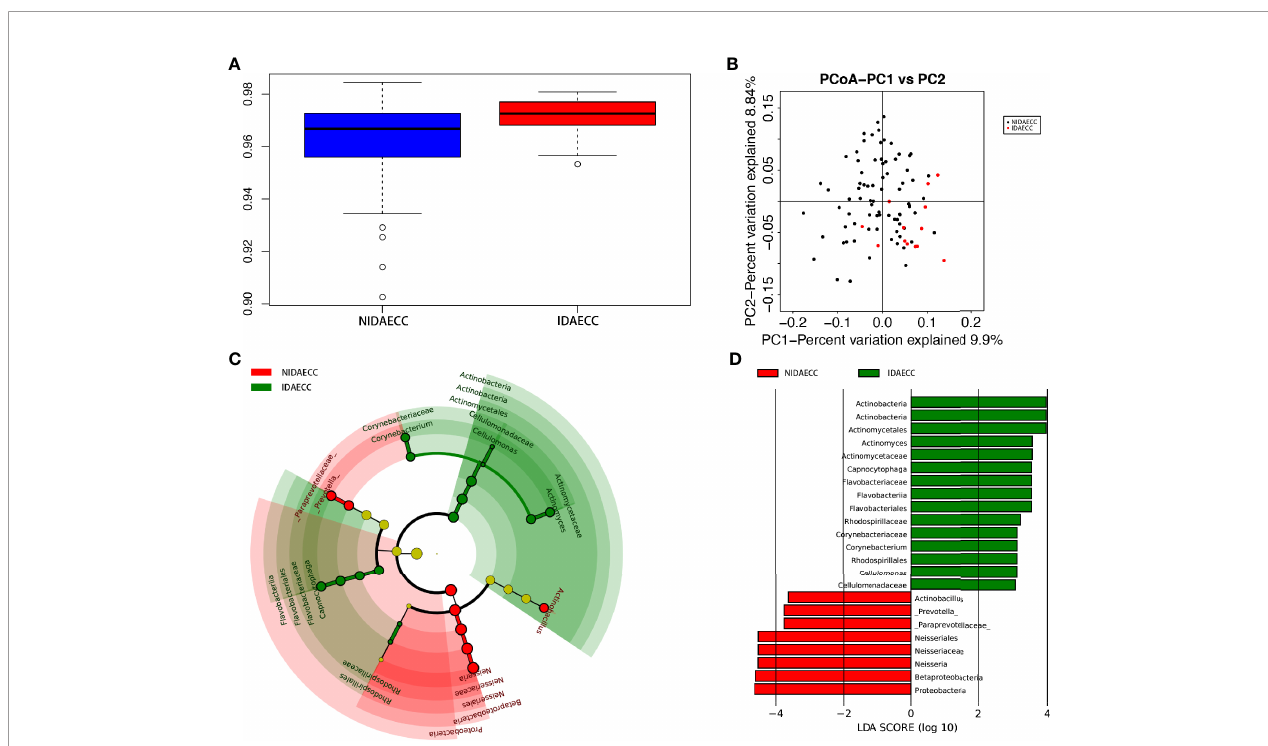
FIGURE 4 | (A) Alpha diversity measurements using Simpson index analysis indicated that IDA ECCs had higher genus diversity than NIDA ECCs (p.simpson = 0.024 <0.05). (B) Unweighted UnifracPCoA analysis. For each sample, the fi rst two principal coordinates (PCo1 and PCo2) from the principal coordinate analysis of weighted UniFrac are plotted. The variance as calculated by PCoA is indicated in parentheses on the axes. NIDA ECC (black dots): saliva samples from IDA-free ECC subjects. IDA ECC (red dots): saliva samples from IDA ECC subjects. (C) Cladogram of taxonomic biomarkers between the IDA ECC and NIDA ECC groups as identi fi ed by LEfSe. Green and red indicate data from the IDA ECC and NIDA ECC groups, respectively. (D) LDA score bar plot of taxonomic biomarkers between the IDA ECC and NIDA ECC groups as identi fi ed by LEfSe. Green represents the IDA ECC group. Genus of bacteria with high content. Red represents the NIDA ECC group. Genus of bacteria with high